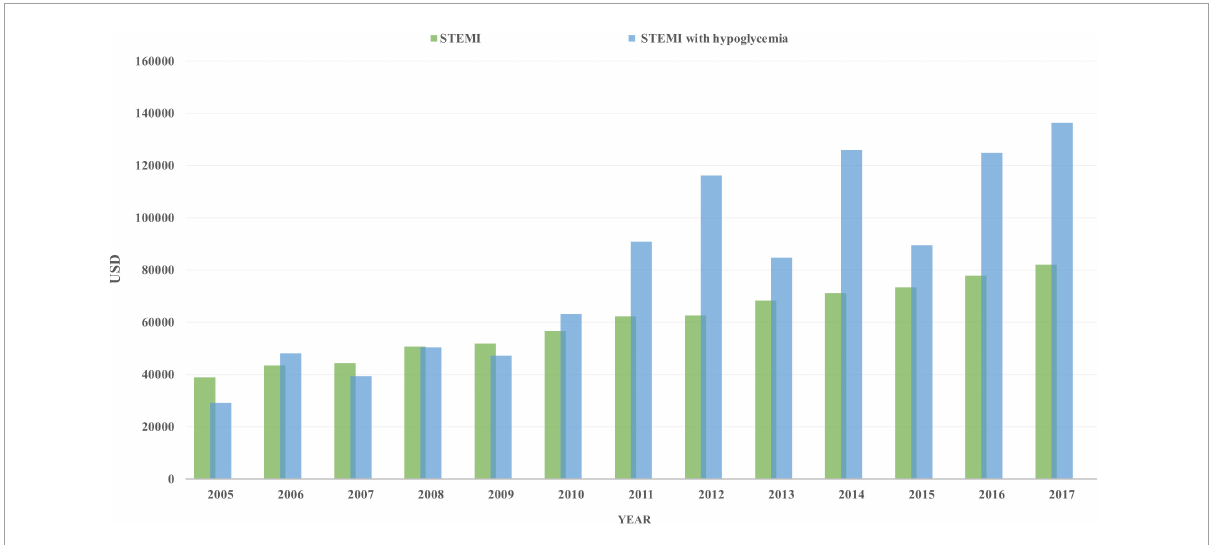
FIGURE2 Total charges/stay (after adjustment for inflation) in STEMI patients with hypoglycemia (blue) and those without hypoglycemia (green), from 2005 to